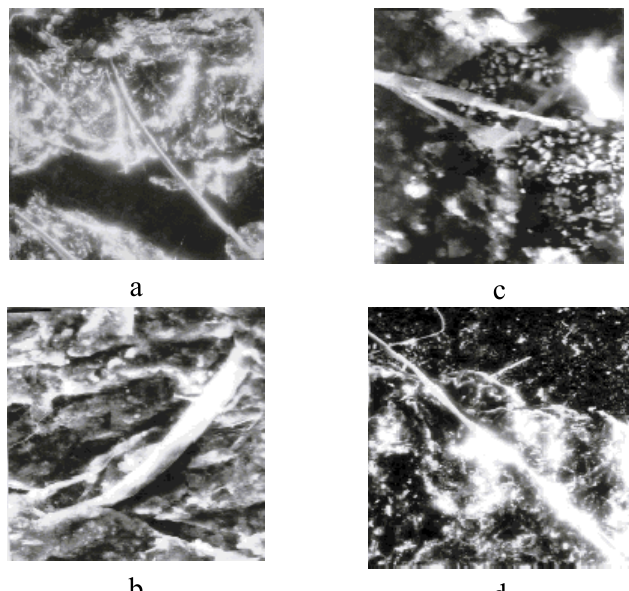
Ba Cu O binder = 85:15 (a, c), 1 2 3 6,97: